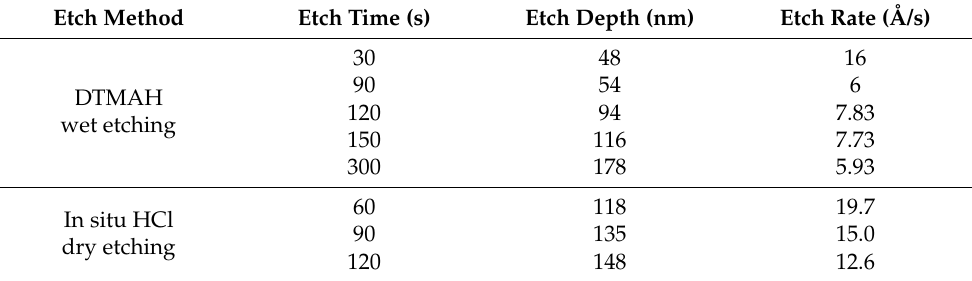
Table 1. Etching rates of the two methods at different